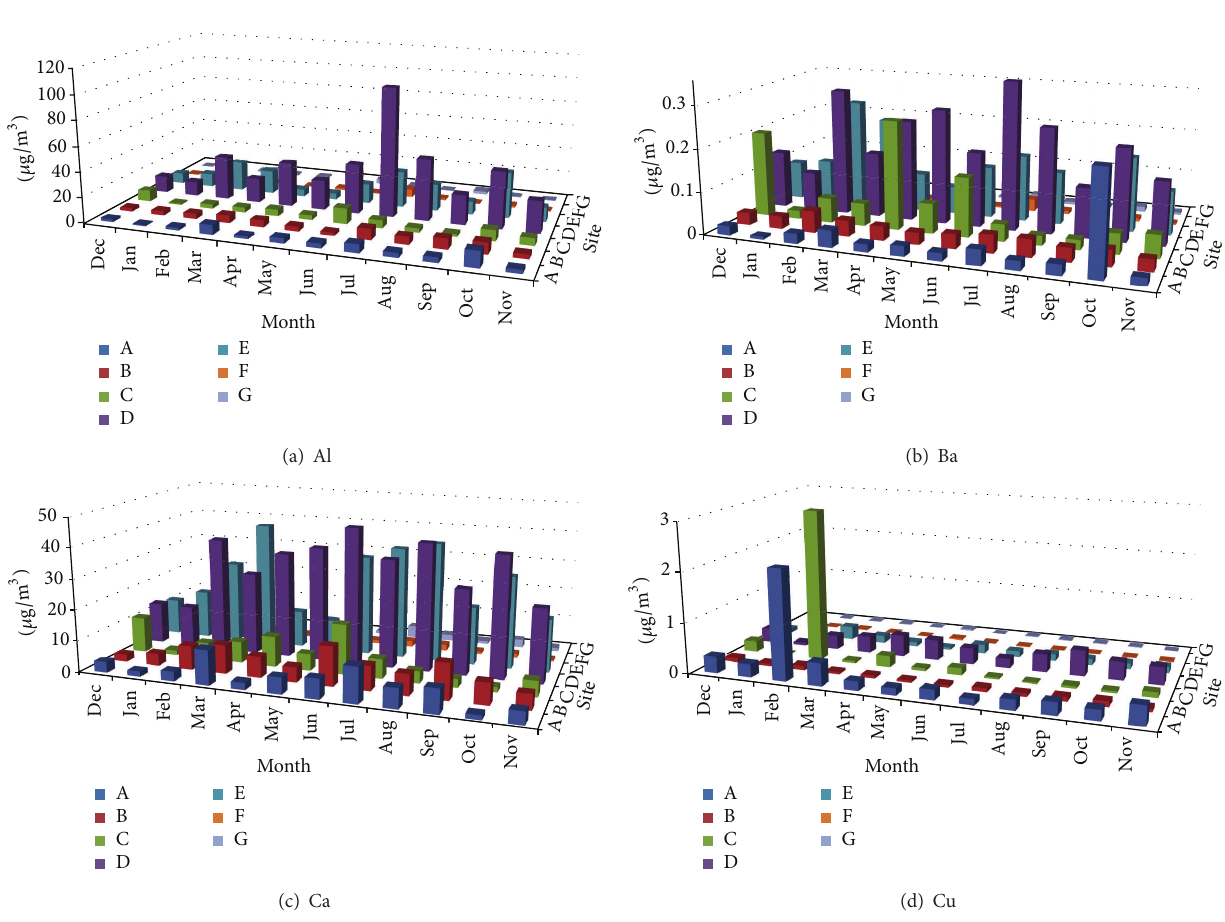
Figure 2: Spatial and temporal distribution of Al, Ba, Ca, and Cu.